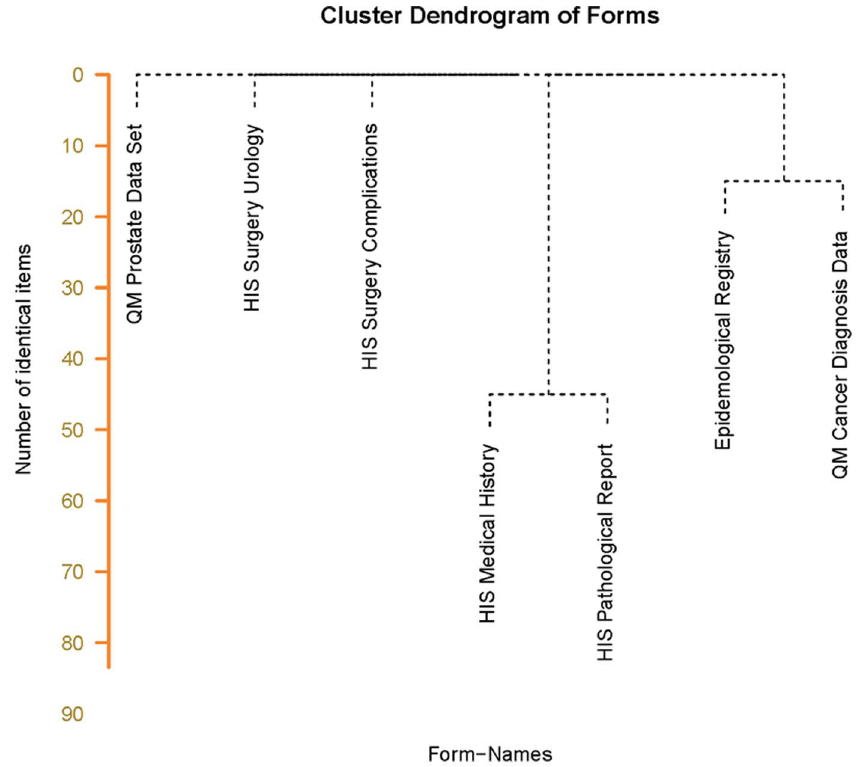
Figure 6. Dendrogram based on the matrix with results of comparison of identical items. This figure shows that similarity between medical history and the pathological report (48 items in common) is higher than between the epidemiological registry form and the quality management form (18 items in common). The other forms do not share identical items.